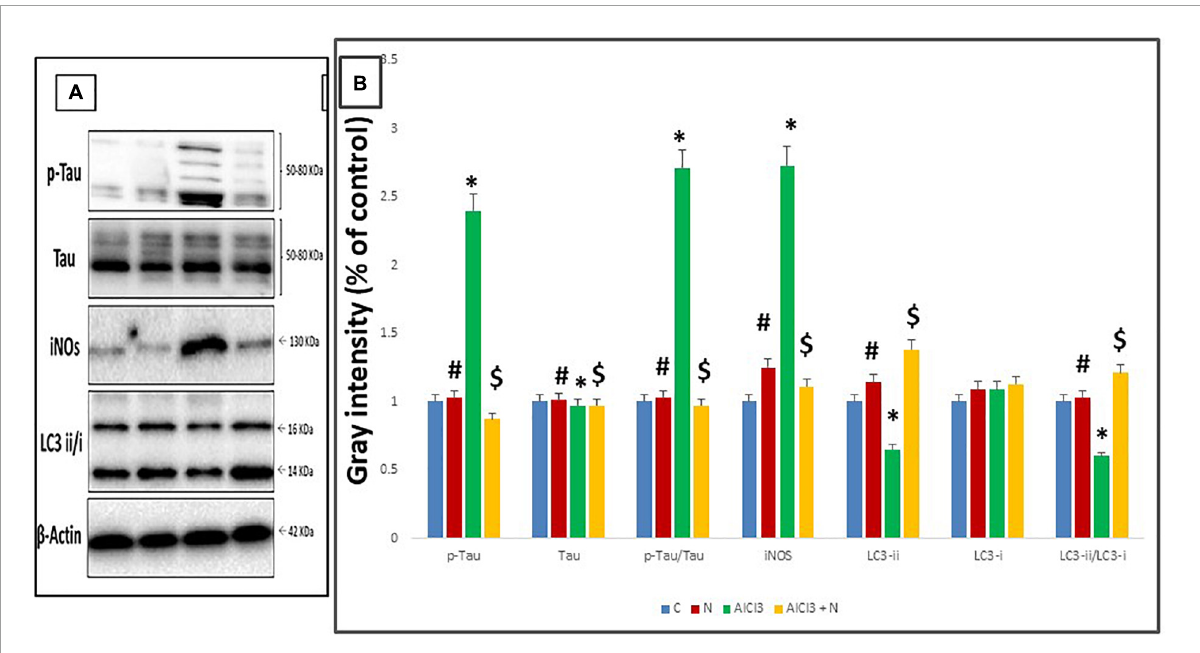
FIGURE10 Western blot analysis. (A) Representative Western blot images of cerebellar tau, iNOS, and LC3 proteins. (B) Quantification of the proteins studied in cerebellar tissue lysates. n = 3 in each group. The control group is set to “1,” and data were prescribed as mean ± SD . The intergroup variation was conducted by Games-Howell post-hoc test. ∗ Significance compared with C group. # Significance compared with AlCl 3 . $ Significance compared with AlCl 3 .